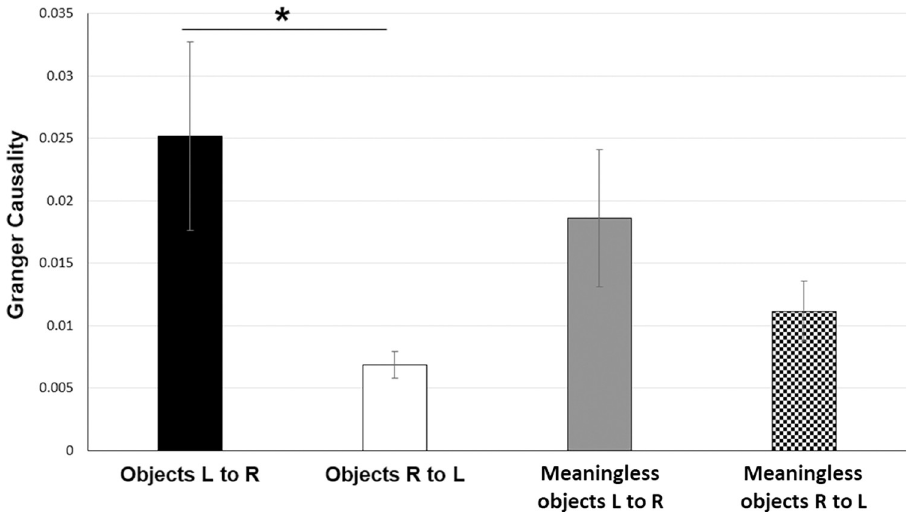
Fig 9. Results of Granger causality (GC) analysis between left and right ROI in source space for the time window of 250–500 ms. Solid black bar represents Left to Right GC for object stimuli; solid white bar represents Right to Left GC for object stimuli; solid grey bar represents Left to Right GC for meaningless object stimuli; checked bar represents Right to Left GC for meaningless object stimuli. Error bars are SEM. Asterisks indicate p < 0.05.